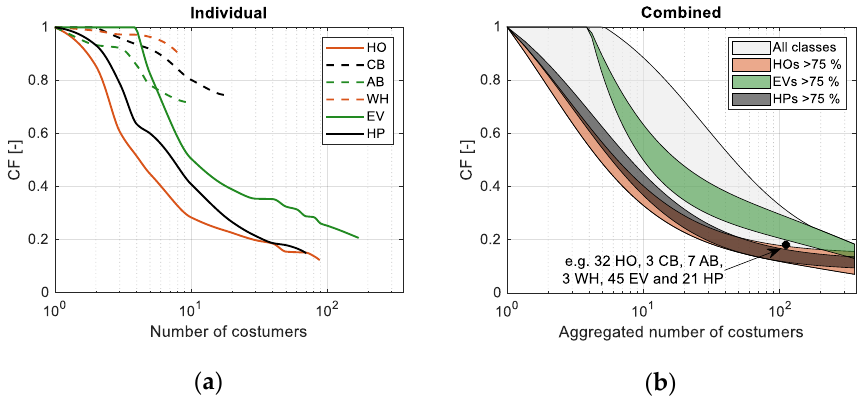
Figure 4. Coincidence factor ( CF ) of various consumer classes modeled individually ( a ) and in a combined way ( b ) including CF -areas predominated (>75%) by households (HOs), electric vehicles (EVs) or heat pumps